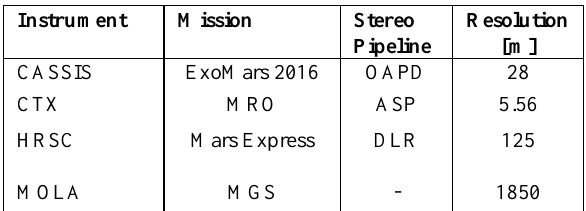
Figure 9 The three DTM covering the region taken in consideration. In (a) the 3D reconstruction performed by OAPD Pipeline on CaSSIS images; in (b) the HRSC dataset; in (c) the CTX -DTM. Dotted line defines the meridian analysed in comparing profiles.